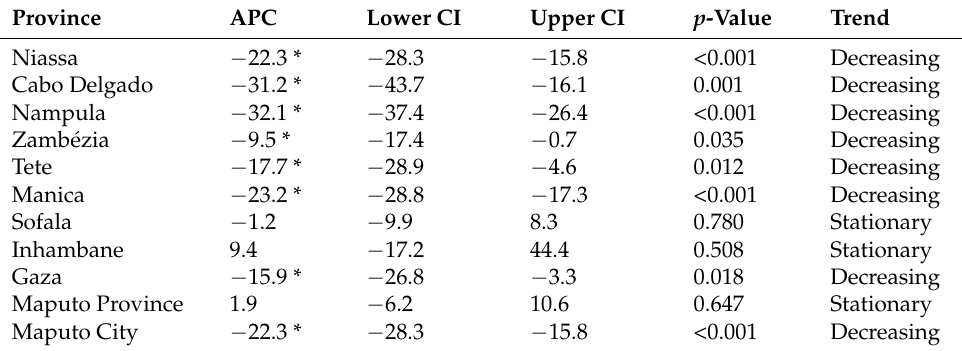
Table 2. Time trend analysis of African swine fever using Joinpoint regression in